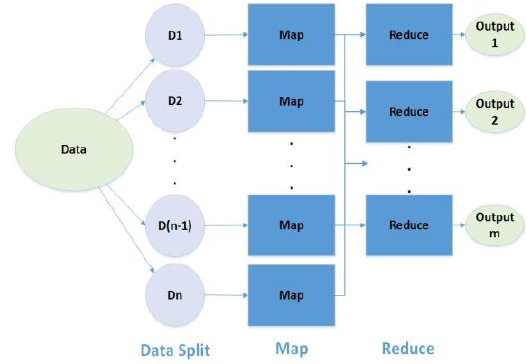
Figure 1. Diagram of MapReduce programming model.